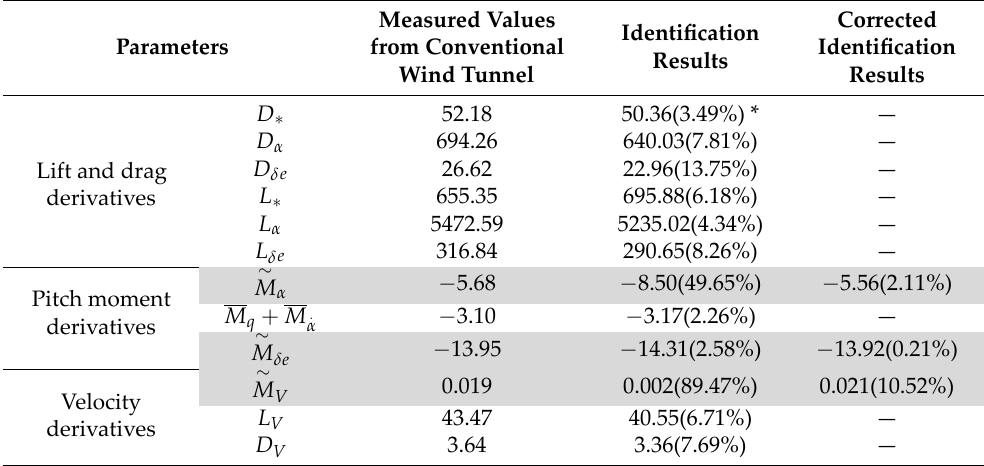
Table 5. Identification results of the aerodynamic parameters.